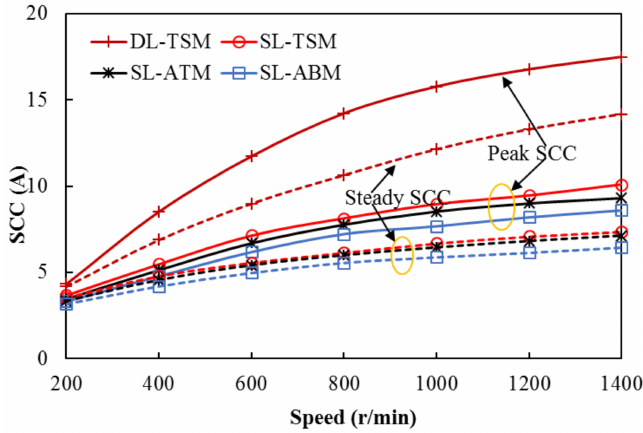
Figure 13. Variation of the three-phase SCC of different machines with